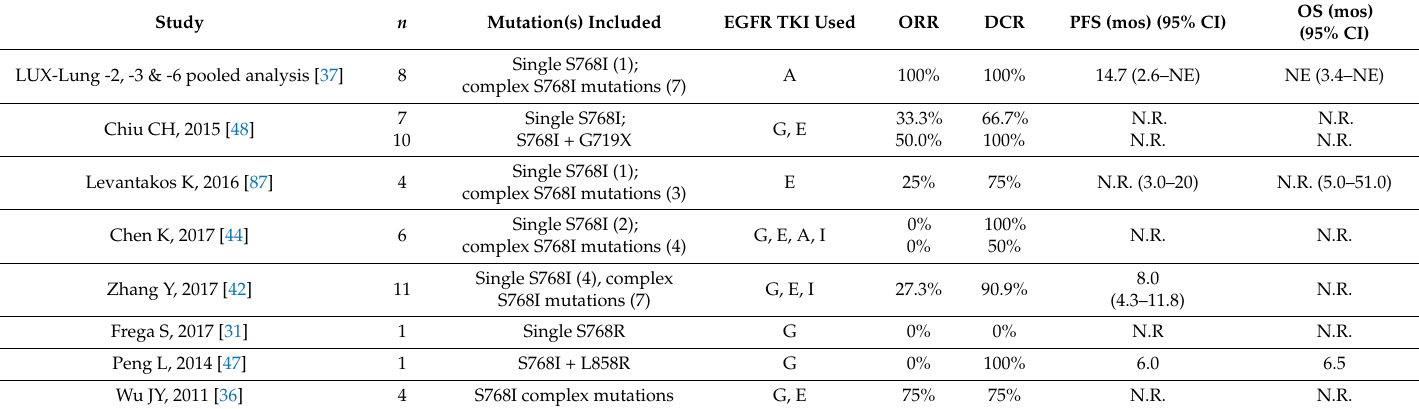
Table 3. Activity of EGFR TKIs in patients with S768X